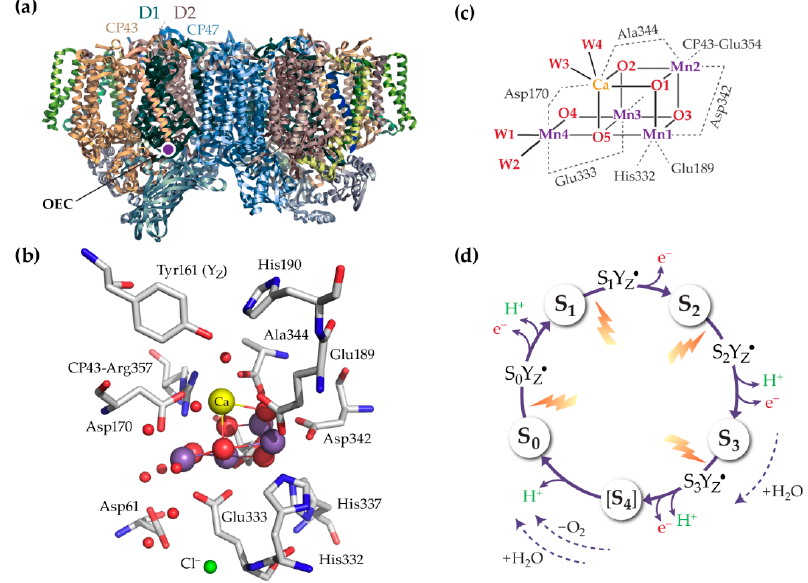
Figure 1. ( a ) Representation of photosystem II, a dimeric membrane-embedded protein complex found in cyanobacteria, algae, and plants, and ( b , c ) the oxygen-evolving complex with its Mn 4 CaO x cluster ligated mostly by carboxylate (Glu and Asp) residues and one histidine (D1-His332). Two terminal water-derived ligands are identified on the Mn4 ion (W1 and W2) and two on Ca (W3 and W4). The redox-active tyrosine Tyr161 (Y Z ) mediates electron transfer from the OEC to the PSII charge separation site. Coordinates are taken from the 1.9 Å resolution crystallographic model of PSII by Umena et al. [27]; ( d ) The cycle of S i states.